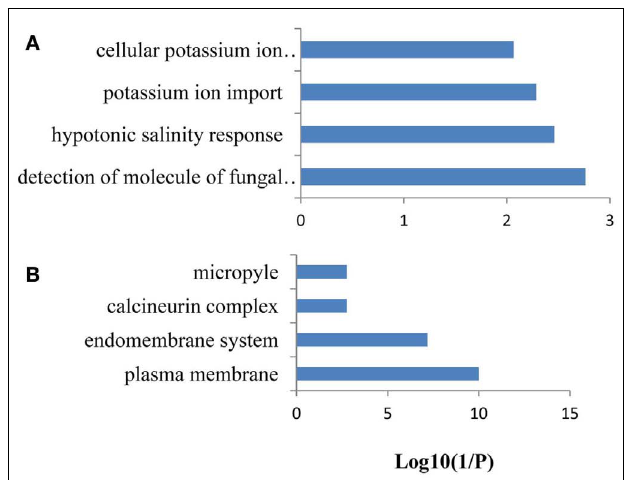
FIGURE 5 | Gene ontology (GO) enrichment analysis of the genes from FEPKPP1 . GO enrichment of the 58 PK and PP genes in the module FEPKPP1 was performed with the GOBU toolbox using theTopGo “elim” method with P < 0.01. (A) GO biological process and (B) GO subcellular